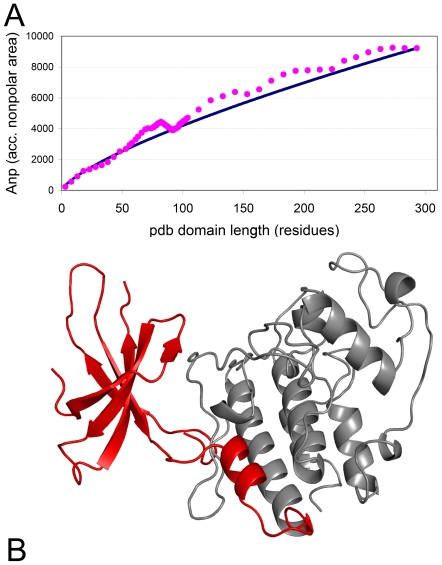
Effect of truncation on the accessible hydrophobic surface of a kinase domain.
(A) Theoretical and actual values for the accessible nonpolar surface area (Anp) of a cyclin-dependent kinase. The C-terminus of the protein structure was gradually truncated and the actual values of Anp (full magenta circles) for the truncated fragments were determined with the CHASA program [22]. They coincide with the theoretical values for an intact domain of the same size (blue contiguous line) around residue 90. (B) Structure of the cyclin-dependent kinase (PDB code 1g3n, chain A). The C-terminal portion missing due to the translocation is colored grey.